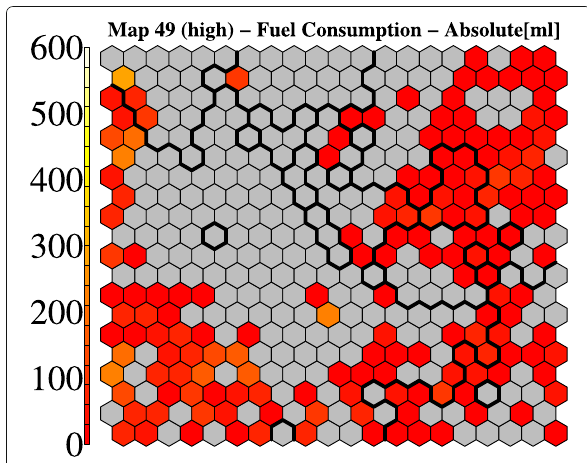
Fig. 12 Trip 49 - Absolute fuel consumption for every manoeuvre Zone node. Trip 49 did not have such very high consump- tion manoeuvres. On the contrary, Trip 53 had less fuel consumption for the total trip. In order to distinguish the manoeuvres observed in the two trips Fig. 14 was constructed where, 1 indicates that the manoeuvre was exclusive to Trip 49, 2 indicates that the manoeuvre was exclusive to Trip 53, and 3 denotes it common to both trips. In Fig. 14, nodes 78 and 79 (Yellow node on the right edge, fourth from the bottom of the map in Fig. 14 is node 80. Its neighbours to the left are 78 and 79), are coloured red and orange respectively. These are nodes present in the Bus Stop Zone or Green cluster. Red denotes, it was observed only in Trip 49 and orange was only present in Trip 53.